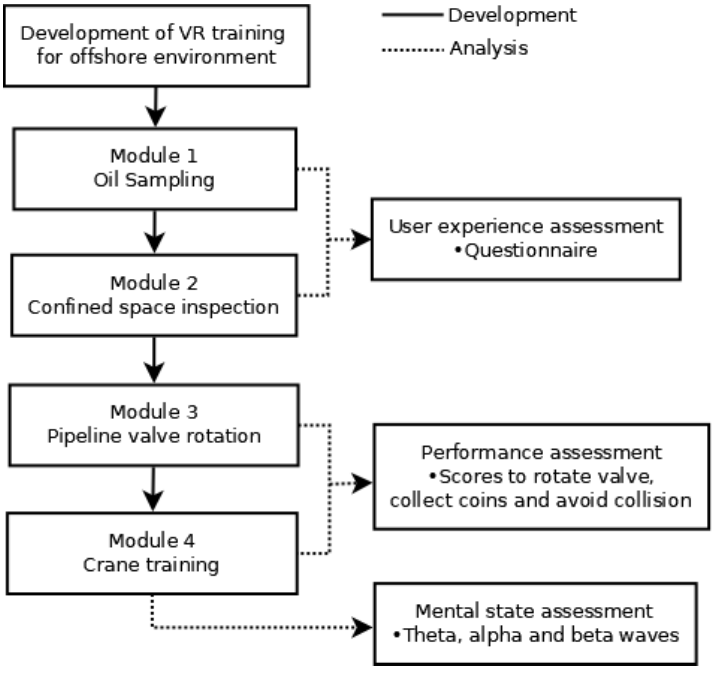
Figure 6. Flow of